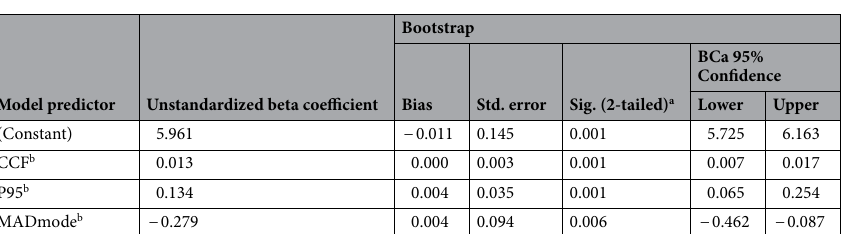
Table 10. Bootstrapping results of the model predictor of the selected model—Model II—10 m radius plot. a The bootstrap beta coefficient is significant at 0.05 level. b CCF: Canopy cover by first returns above 3.66 m (CCF), 95th Height Percentile (P95) and median of absolute deviation from mode (MADmode). The bootstrapping test on the model bias showed that there was minimal level of bias (bias <